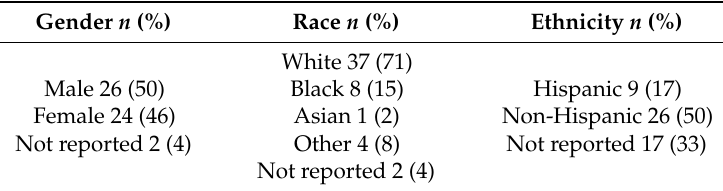
Table 1. Participant demographics.